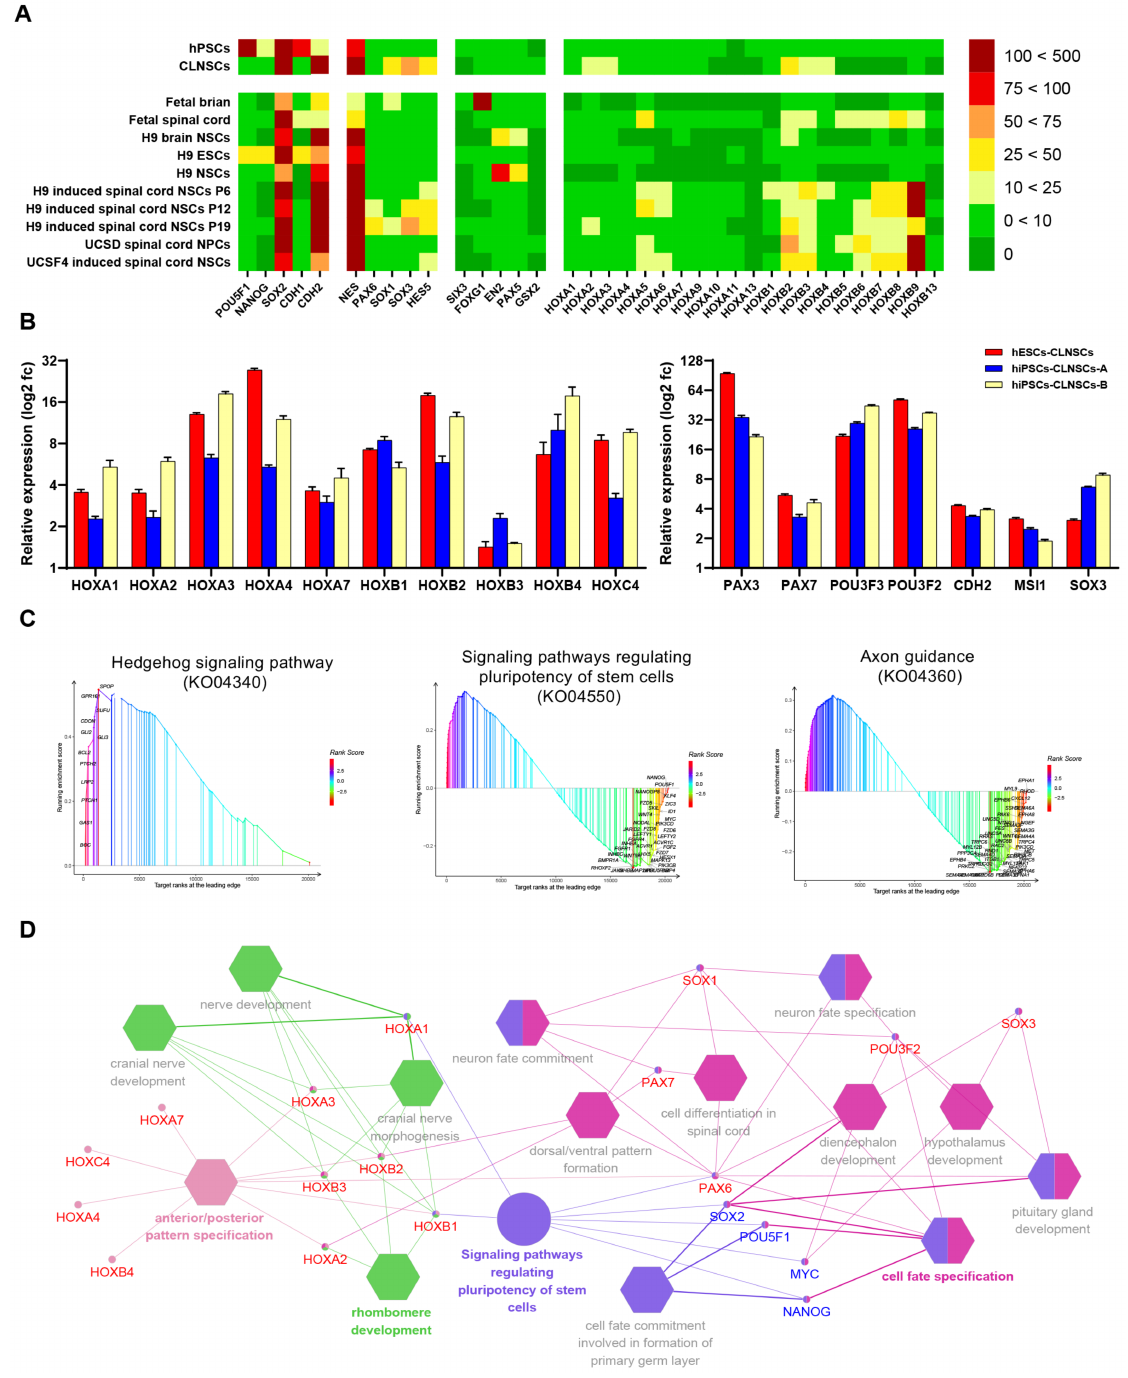
Figure 5. The spinal cord region-specific expression pattern in CLNSCs. ( A ) Expression levels of pluripotent markers, ectoderm markers, brain markers, and HOX genes in CLNSCs and fetal brain, fetal spinal, H9 ESCs, H9 NSCs, and induced spinal cord NSCs were compared by RPKM; the scale bar shows RPKM values. ( B ) qRT-PCR analysis of HOX genes and the expression of neural genes in different CLNSC lines were presented as log2 (fold change). The relative expression was determined by comparison to the hPSC cell lines. ( C ) KEGG pathway neural development-associated enrichment in NSCs by GSEA. The peak in the graph divides the curve into two sides. The first side is called the leading edge, and the genes on this side are leading targets that are worth exploring. The abscissa is target ranks, which indicates the ranking of targets, and ordinate is the enrichment score. ( D ) The network of candidate targets was constructed using Cluego analysis in Cytoscape. The circle indicates the KEGG pathway, and polygons indicate GO terms. Genes labeled red indicate the up-regulated genes and those labeled blue indicate the down-regulated